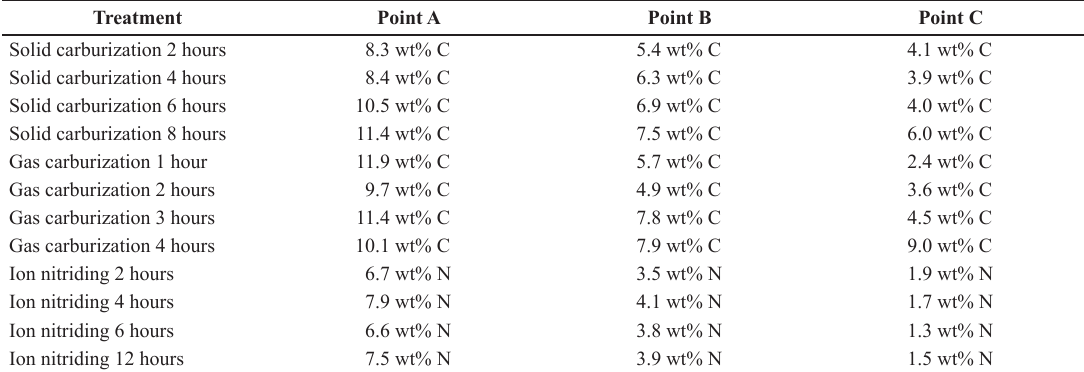
Table 6- Chemical composition of layers